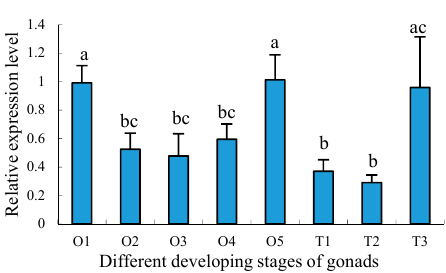
Figure 9. Distribution pattern of Sp-uchl3 in different developing stages of gonad. O: ovary, T: testis, number: stage of development. Different lowercase letters above error bars indicate significantly differential expression ( p < 0.05).